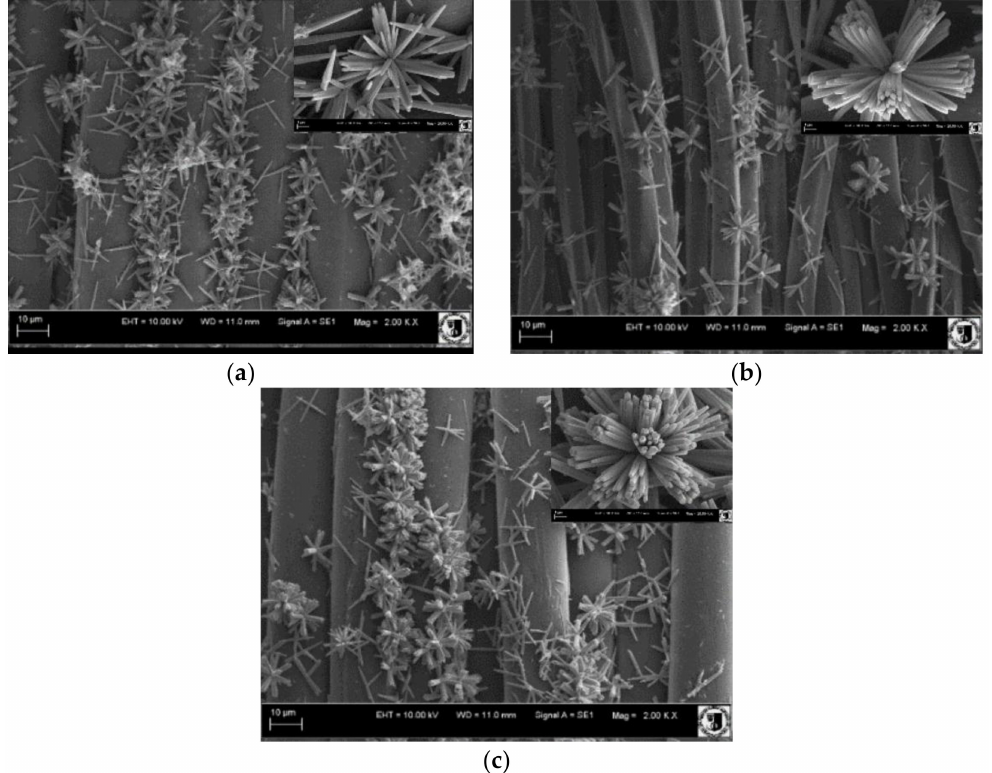
Figure 7. SEM images of ZnO deposited on: ( a ) PA; ( b ) PET; and ( c )